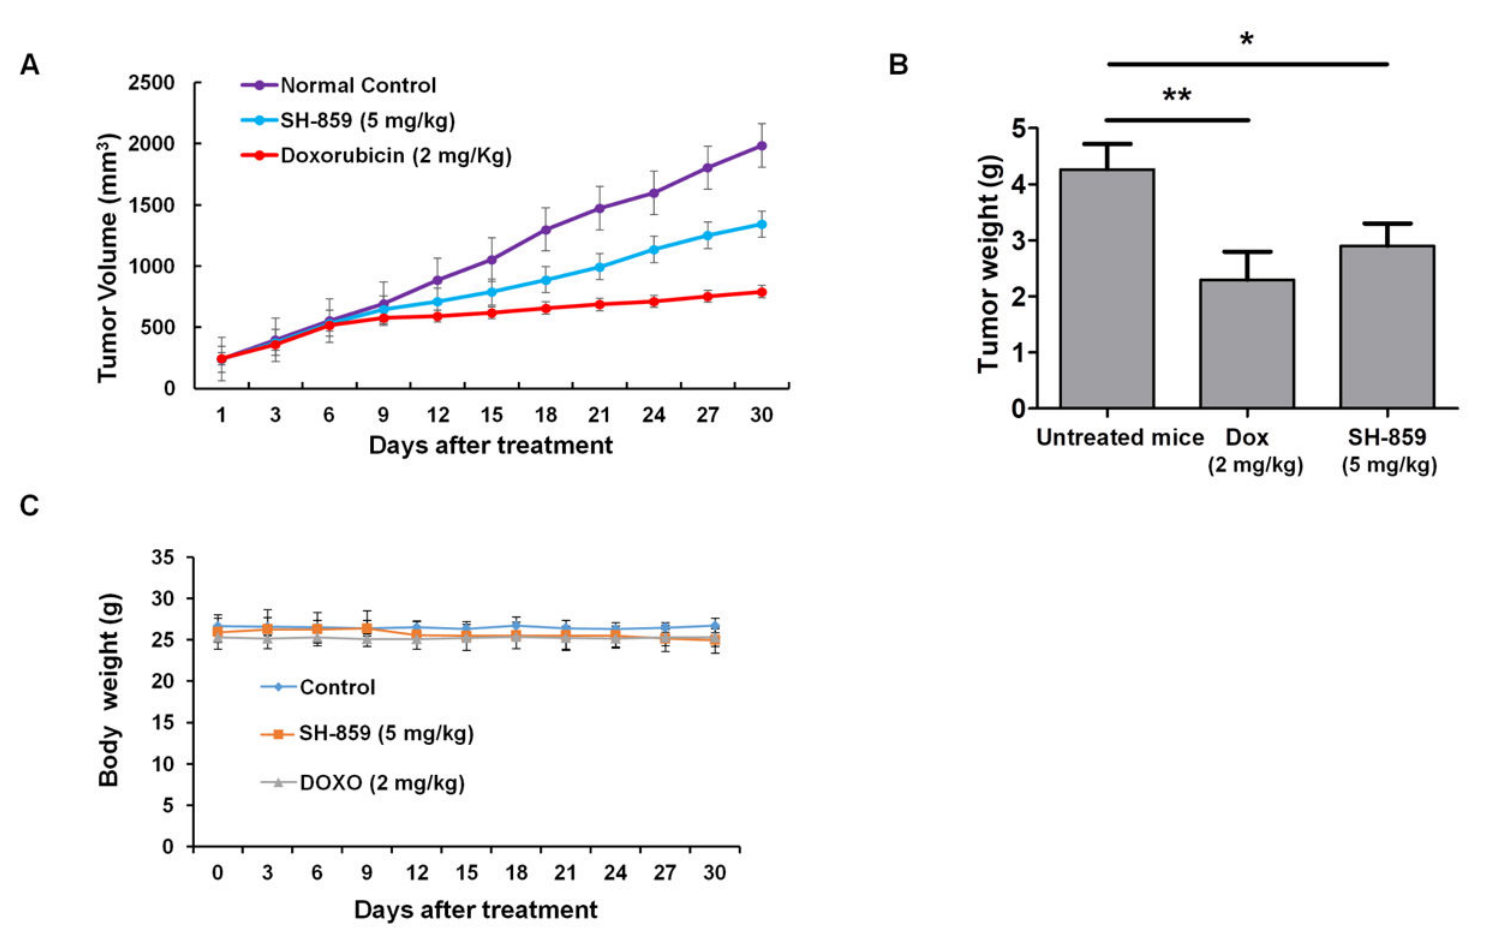
Figure 6. E ff ect of SH-859 in the tumor xenograft model. Nude mice ( n = 5) were injected with 786-O cells intraperitoneally. Thereafter, the mice were treated with vehicle (control) (untreated mice), SH-859 (5 mg / kg, twice a week, p.o.) (test), and doxorubicin (2 mg / kg, once a week, intraperitoneally (i.p.)) (standard) for 30 days. ( A ) Tumor volume, ( B ) tumor weight and ( C ) body weight changed after treatment with SH-859 and doxorubicin. Data are represented as mean ± SE. * p < 0.05 and ** p < 0.01, compared with